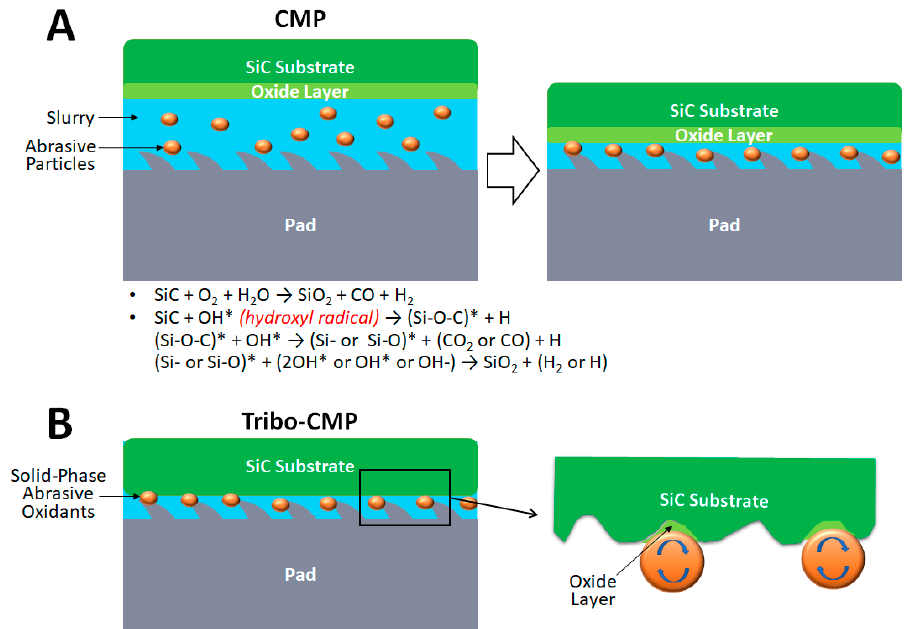
Figure 3. ( A ) Illustration of CMP mechanism. The oxidants in the slurry oxidize the SiC surface into a softer oxide layer which can be removed by the abrasive particles in the slurry and the conditioned CMP pad simultaneously. The chemical reactions of SiC oxidation, which are initiated by either oxygens or hydroxyl radicals, are shown [7,8]. Note that asterisk represents radicals. ( B ) Illustration of Tribo-CMP mechanism. In addition to the global oxidation taking place at the slurry and SiC interface, localized oxidation can also occur when the solid-phase abrasive oxidants roll on the SiC wafer